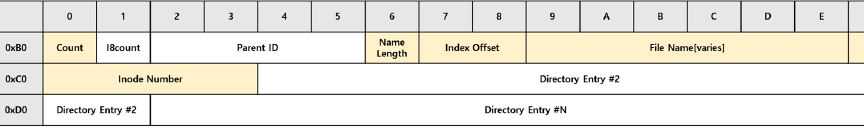
Figure 8. Directory entries structure of XFS file system.